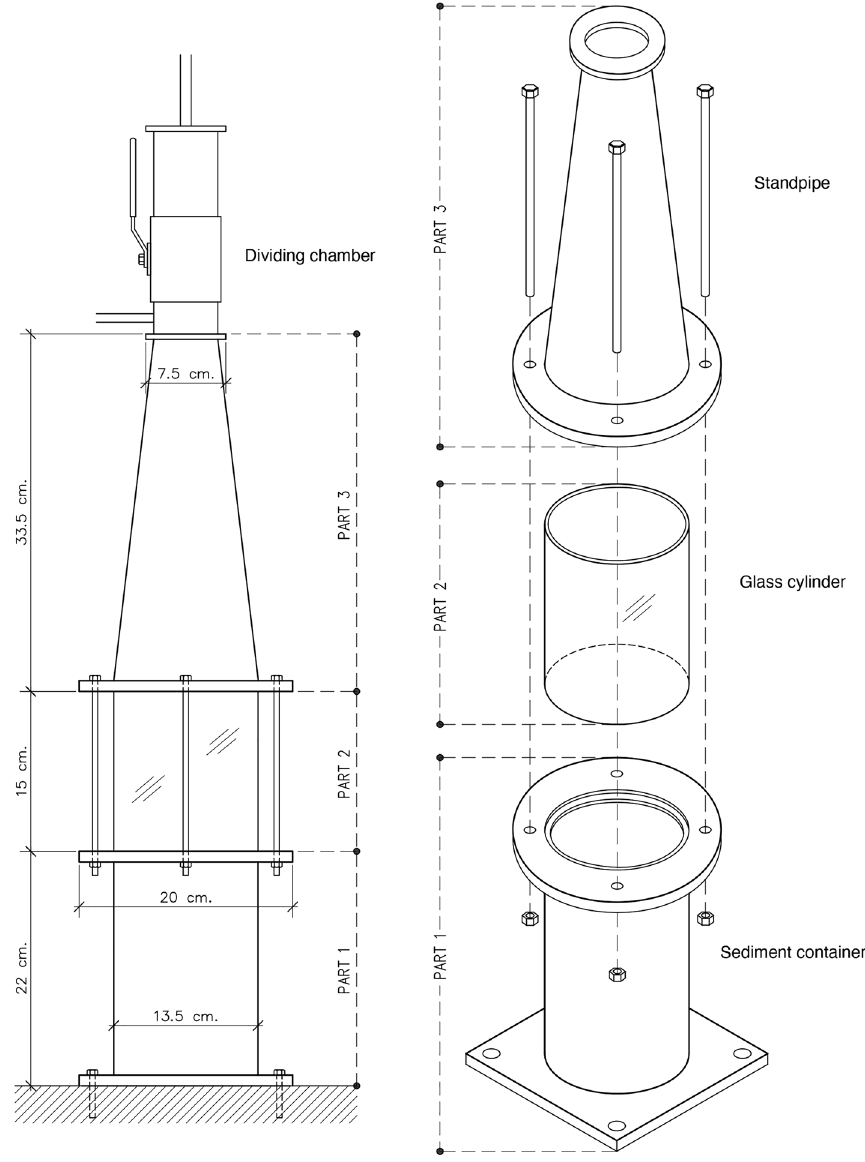
Figure 1. The Kristineberg microplastic sediment separator (KMSS) designed after the Munich plastic separator (Imhof et al., 2012). Part 1, sediment container with a rotor and a bottom valve, part 2, glass cylinder, part 3 standpipe, and top part dividing chamber with ball valve and filter